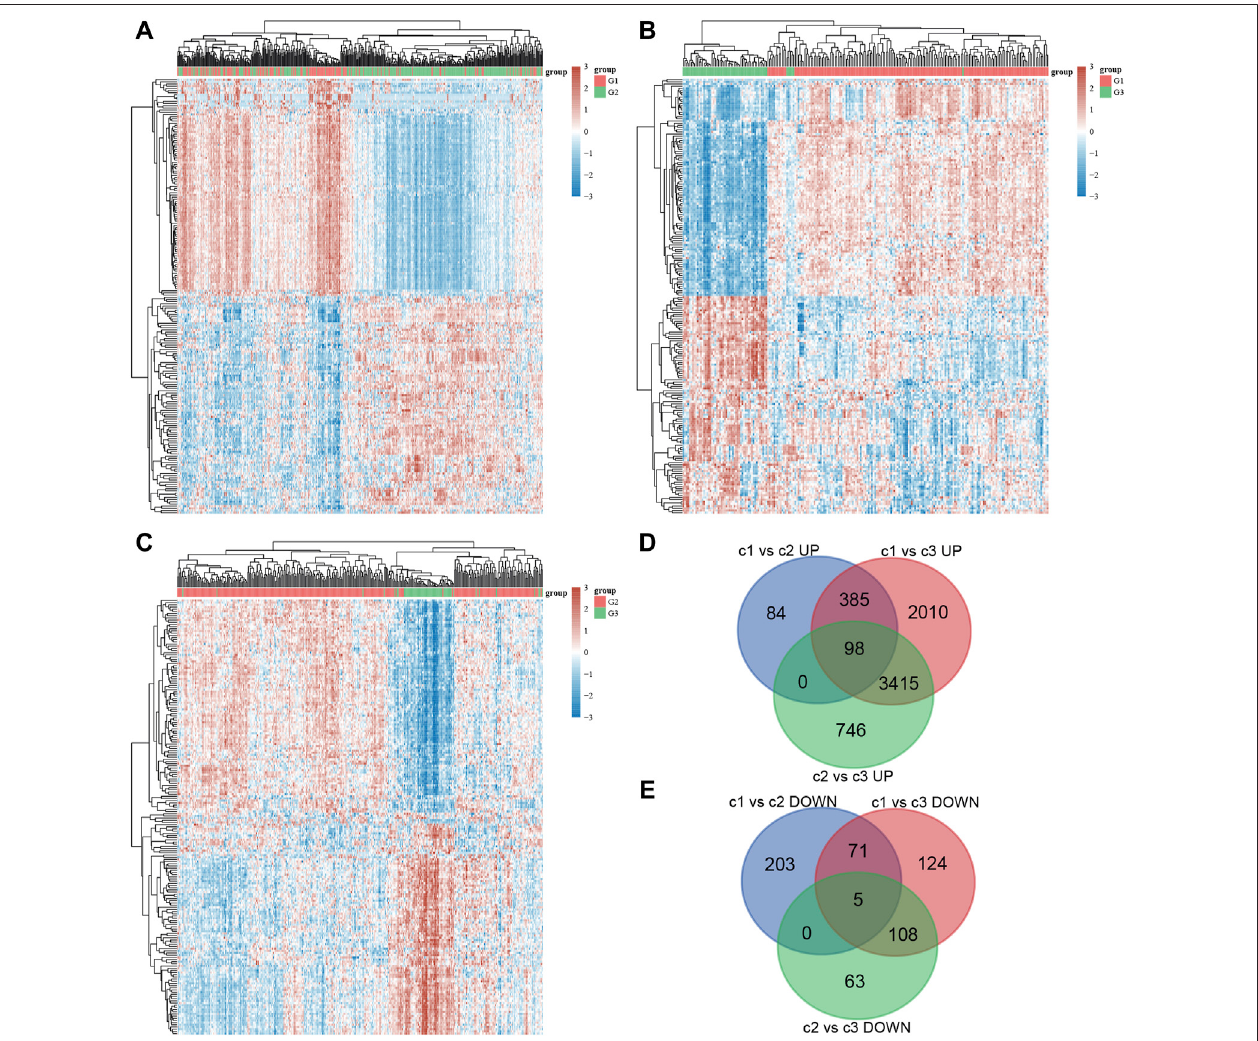
FIGURE 5 | DEGs analysis of different stress granule subtypes in NSCLC. (A) Heatmap analysis showed DEGs between subtype 1 and subtype 2 of NSCLC. (B) HeatmapanalysisshowedDEGsbetweensubtype1andsubtype3ofNSCLC. (C) HeatmapanalysisshowedDEGsbetweensubtype2andsubtype3ofNSCLC. (D,E) Venn map analysis of DEGs analysis in different stress granule subtypes of NSCLC.